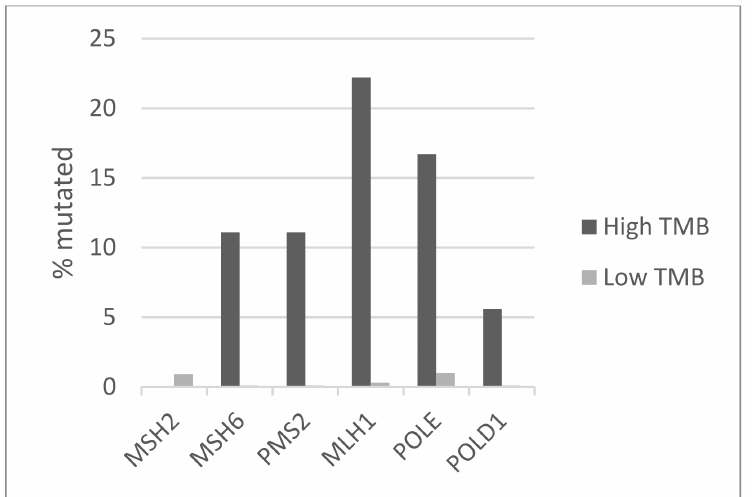
Figure 2. Prevalence of mutations in mismatch repair-related genes and genes encoding for poly- merases POLE and POLD1 in luminal breast cancers according to TMB. The total non-overlapping prevalence of these mutations in the high TMB group is 44.4% and in the low TMB group is 2.6% (Fisher’s exact test p < 0.000). High TMB group: >10 mutations/MB; low TMB group: ≤ 10 mutation/MB. Data are from TCGA. TMB—tumor mutation